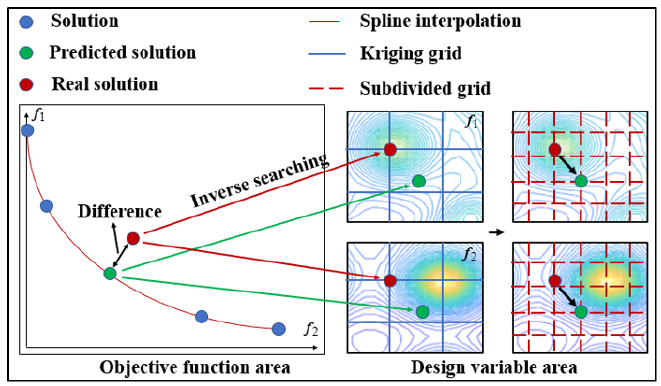
Figure 3. Conceptual diagram of Subdivided kriging grid.